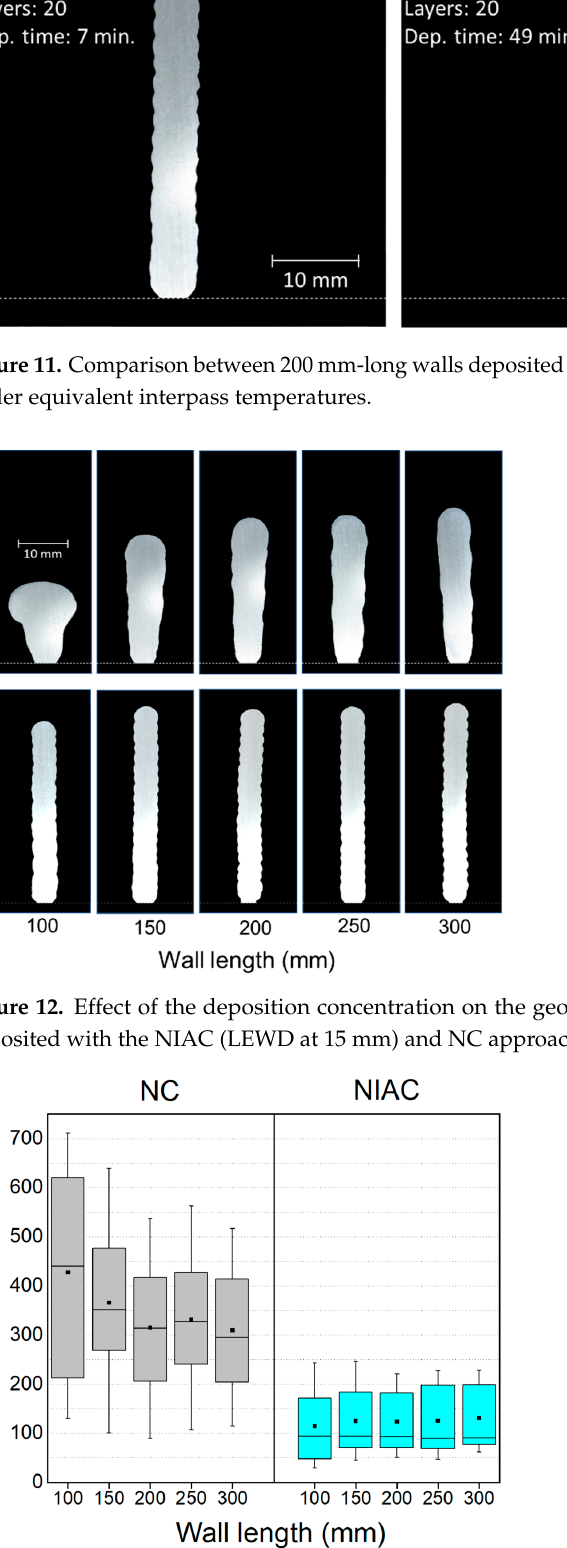
Figure 12. Effect of the deposition concentration on the geometry of walls with different lengths deposited with the NIAC (LEWD at 15 mm) and NC approaches. Figure 13. Comparison between temperature data distributions of walls built with different lengths under the NIAC (LEWD at 15 mm) and NC approaches.